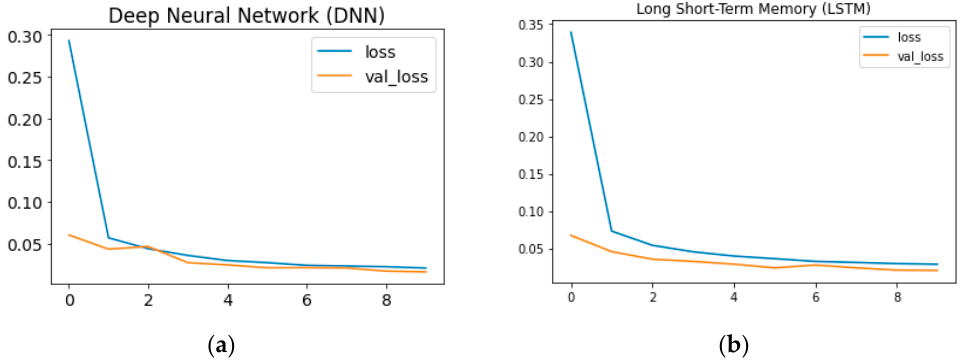
Figure 12. Loss and Validation Loss Graphs for ( a ) DNN; and ( b )